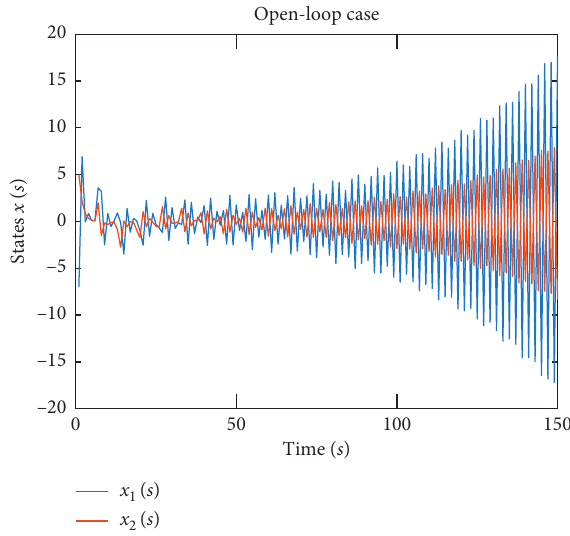
Figure 1: The state trajectories of open-loop DTNSNSs (5) with time